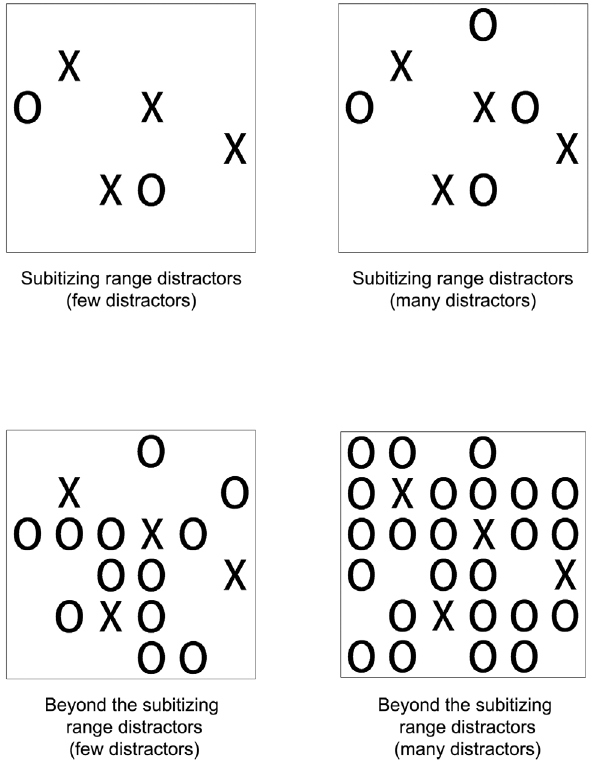
Figure 2. Examples of the displays in the various conditions in Experiment